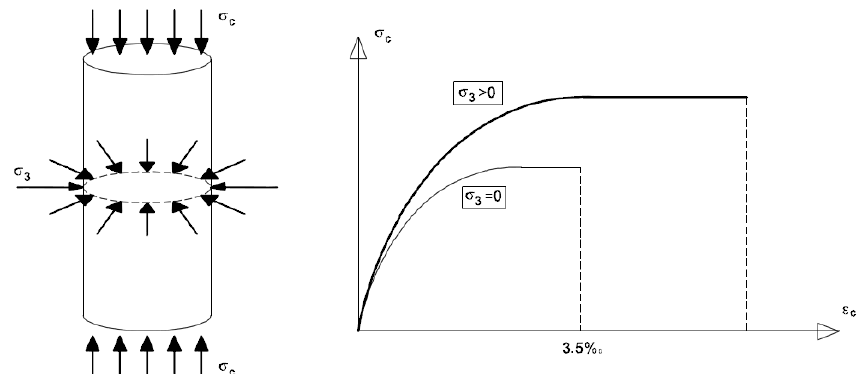
Figure 1: The stress-strain relationship of compressed concrete with and without confinement [4].